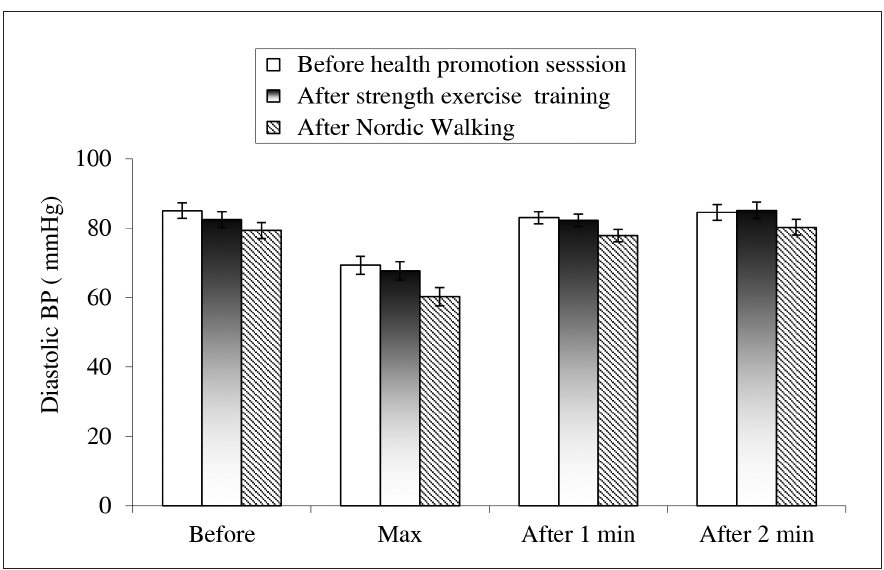
Figure 4. Diastolic ABP changes while performing Roufier Exercise